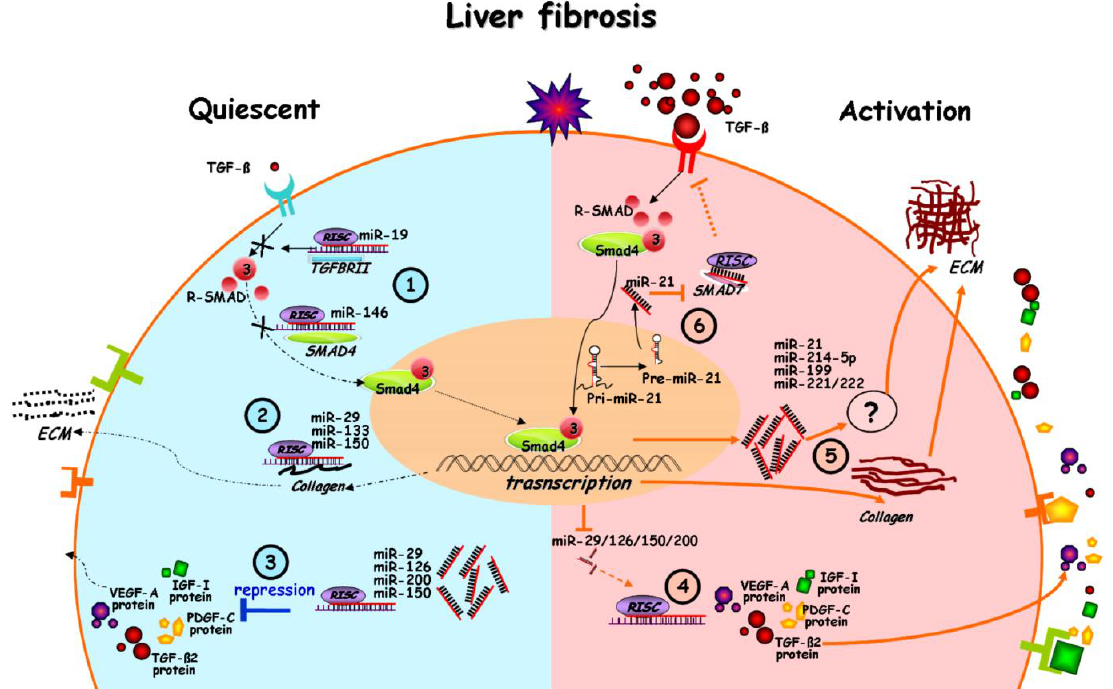
Figure 2. miRNAs in the interplay of signaling in quiescent and activated HSCs after chronic liver